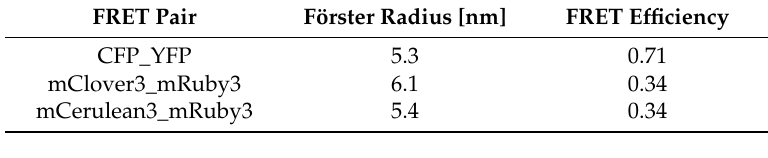
Table 2. Characteristics of the FRET constructs.